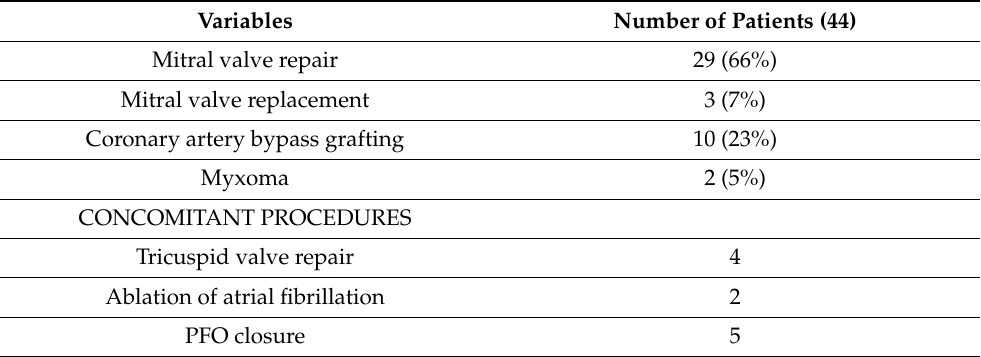
Table 1. The overall population treated with robotic surgery since January 2021 at Bordeaux Univer- sity